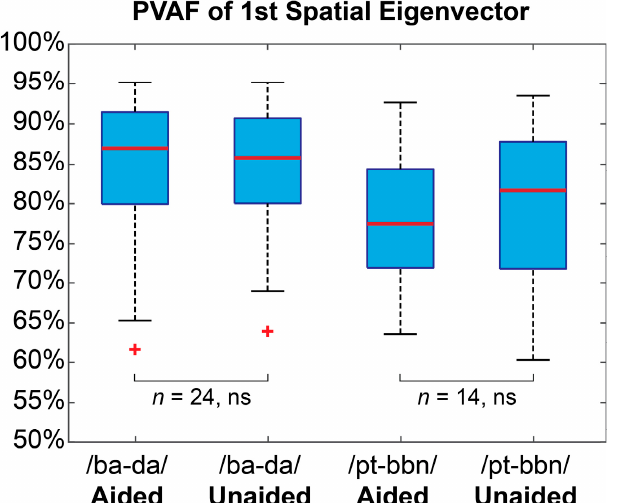
Figure 2. Spatial eigenvector variances. Boxplots represent distributions for the percentage of variance accounted for (PVAF) by the first spatial eigenvector of four EEG channels (Fz, Cz, M1, and M2) for the aided and unaided conditions and for each contrast. Statistical comparisons between the aided and unaided conditions were computed separately for each contrast ( ns = not significant, p > 0.05). + signifies points that are outside of the interquartile range.